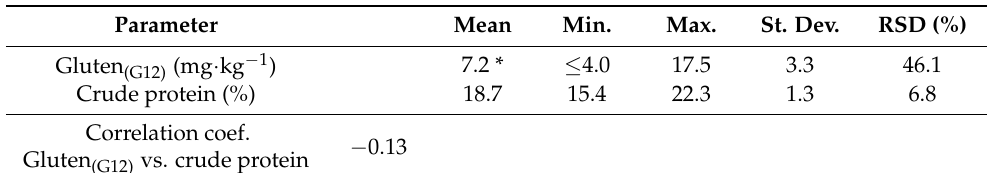
Table 2. Basic data on detected cross-reactive avenins (gluten (G12) ) and crude protein content in the tested set of 132 oat cultivars